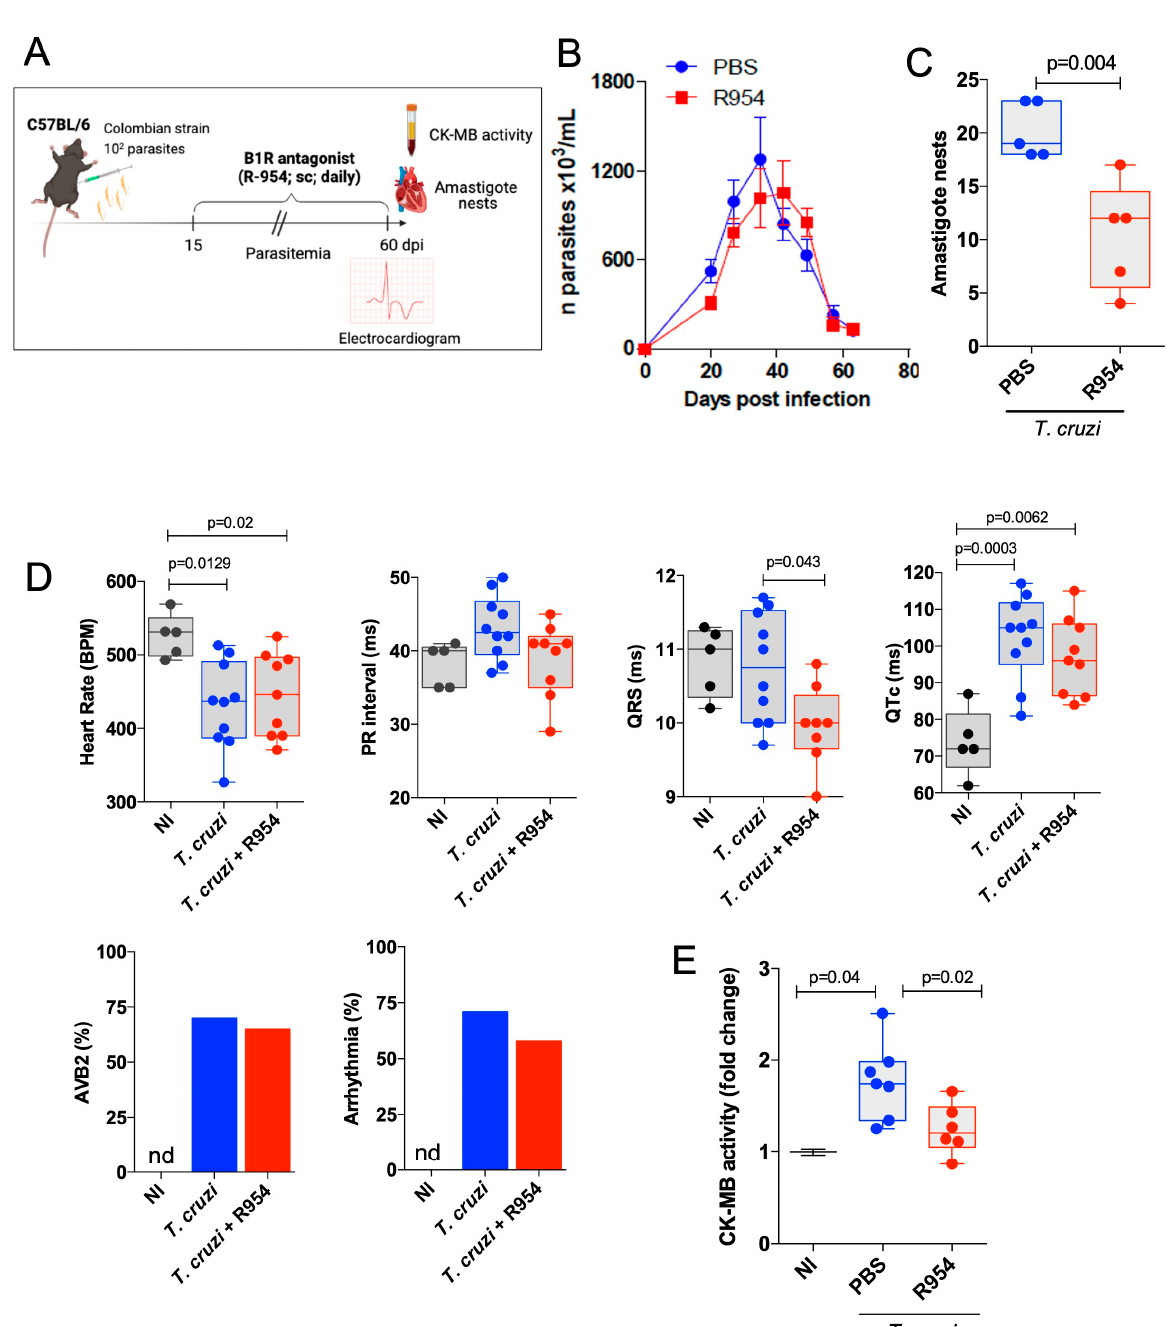
Figure 3. Beneficial effects of early B1R targeting in WT mice systemically infected by the myotropic Colombian T. cruzi strain. ( A ) Schematic figure of the infection model and treatment protocol. C57BL/6 (WT) mice were systemically infected (i.p.) with bloodstream Col TCTs (10 2 parasites). Daily B1R antagonist (R-954) treatment (1.6 mg/Kg; s.c.) started at 15 dpi and lasted up to 60 dpi., whereas the control mice received PBS. ( B ) Parasitemia was followed daily. After 60 dpi, heart tissues were fixed and sections (3 µ m) were stained with T. cruzi -specific antibody for detection of amastigote nests. Results expressed in 100 fields ( C ). ( D ) Electrocardiogram records obtained at 60 dpi in diazepam sedated mice C57BL/6 mice: heart rate (bpm), PR interval, QRS, QTc, AVB2, and frequency of arrhythmias. ( E ) CK-MB activity was quantified in the serum and the results expressed by fold change. The results are representative of two independent experiments; bar shows media ± SD and each symbol represents one mouse (n = 8–10 mice/group/experiment). Statistical analyses were performed by one-way analysis of variance (ANOVA) test. p values < 0.05 were considered significant. nd,